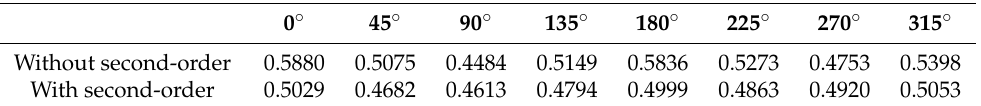
Table 6. Accumulative damage at different assessment points of the tower-base with and without second-order